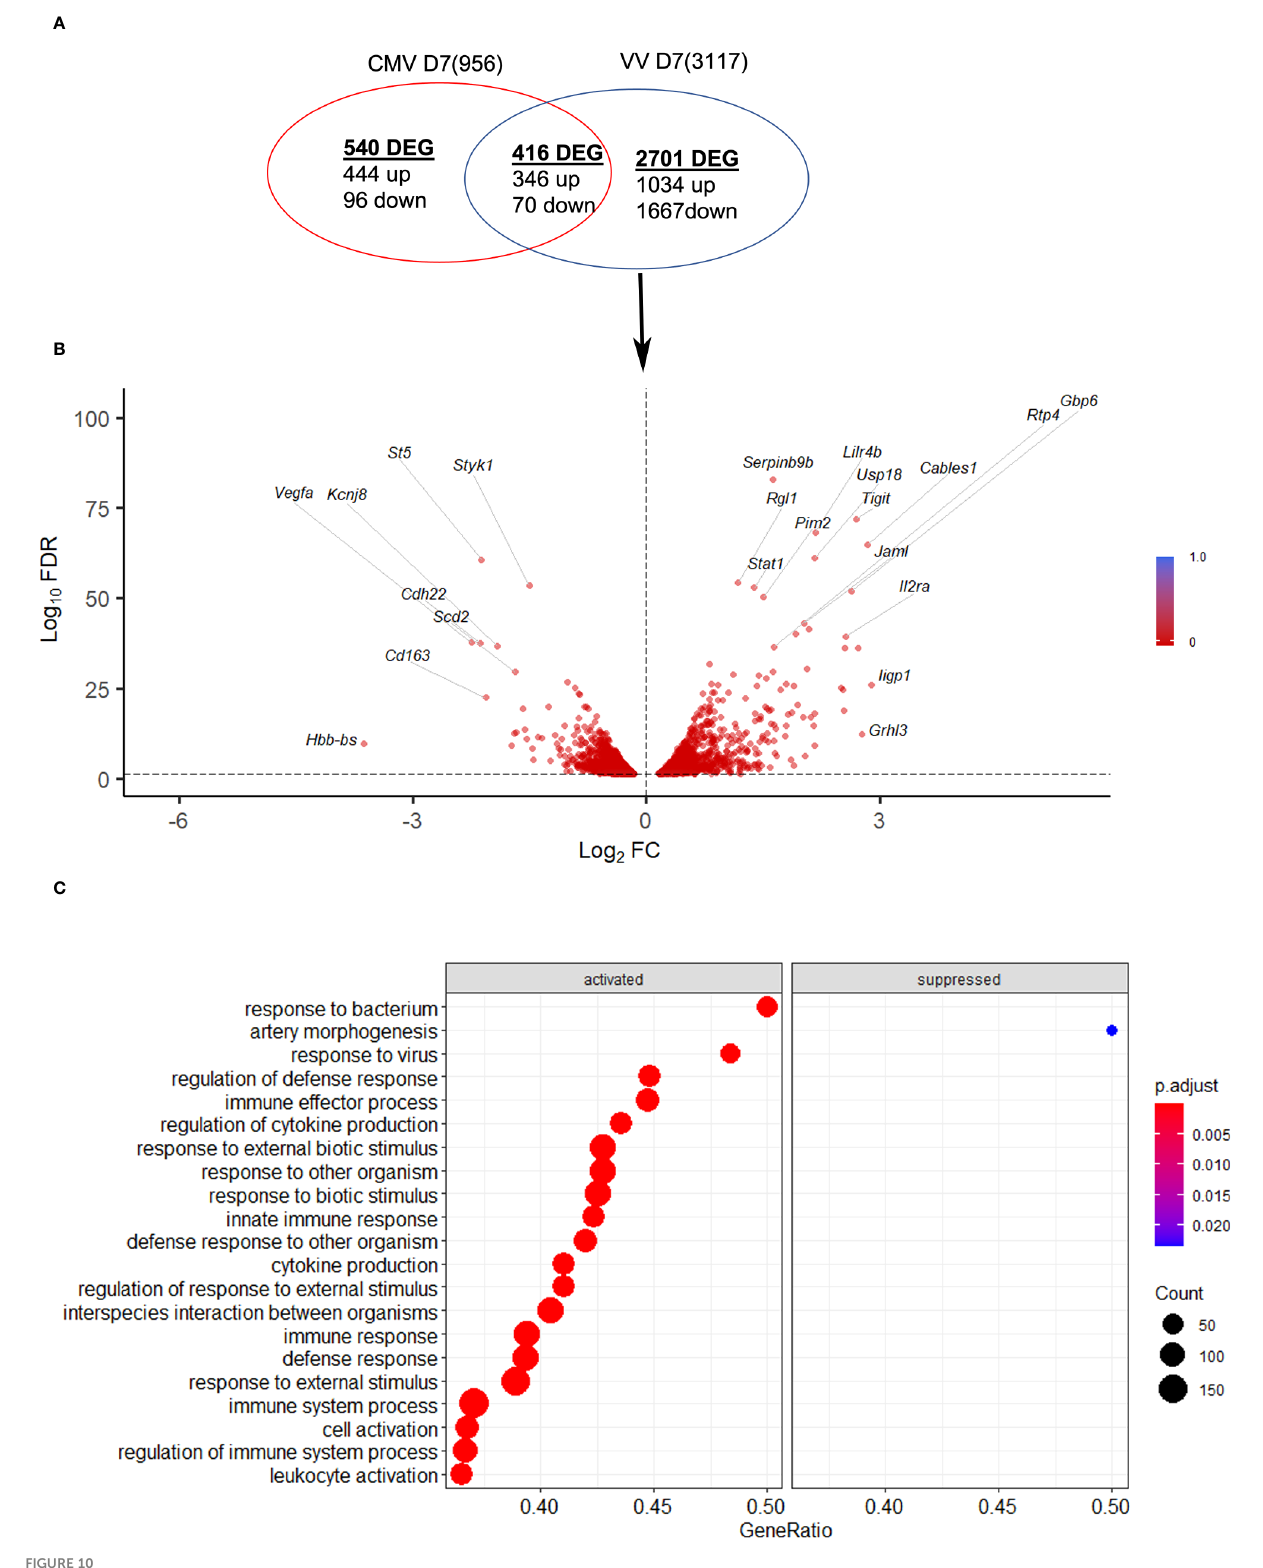
FIGURE 10 mCMV and VACV induce different NK transcriptional pro fi les in infected mice. (A) Venn diagram showing the number of DEGs (FDR<0.05) (upregulated or downregulated) associated with VACV and mCMV infection in NK cells at 6.5 d.p.i. The total number of genes detected in each dataset is indicated in brackets. (B) Volcano plot of DEGs modulated after VACV, but not mCMV infection, in NK cells. (C) Biological processes gene ontologies enriched among gene differentially expressed uniquely by VACV but not